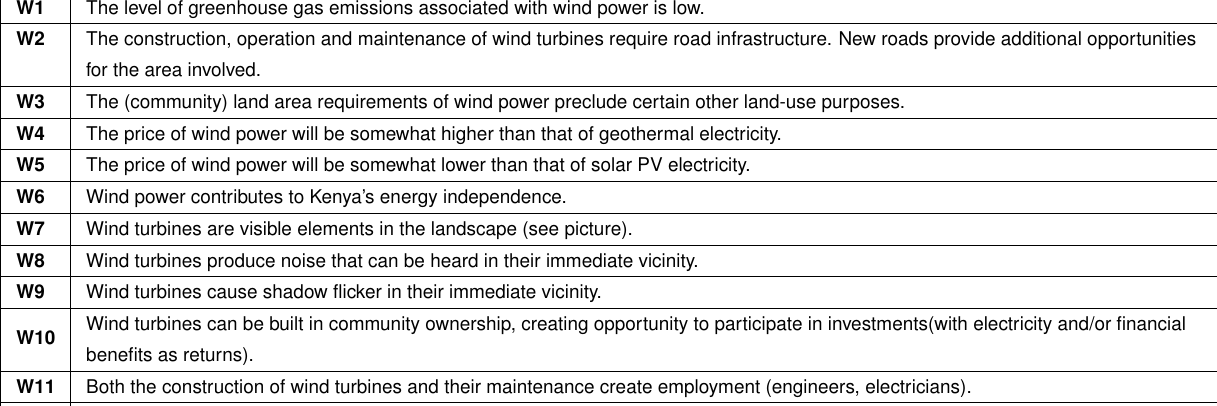
Table 1. Overview of the questions about wind, PV, and geothermal energy. Wind